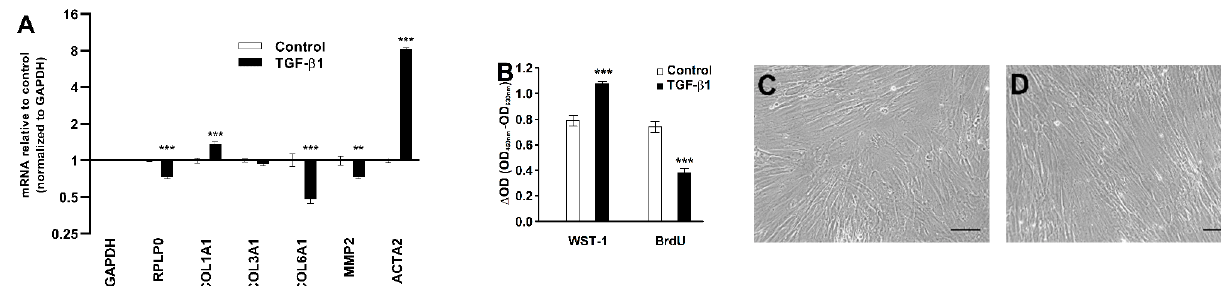
Figure 6. Effect of TGF- β 1 (1 ng/mL) treatment of CoReFs for 48 h on COL1A1 , COL3A1 , COL6A1 , MMP2 , and ACTA2 mRNA levels ( A ) and cell proliferation measured by WST-1/BrdU assays ( B ). Phase contrast photomicrographs (Olympus CK40 with Moticam ® S2) of CoReFs treated without ( C ) or with TGF- β 1 ( D ) for 48 h just before adding the WST-1 reagent. Scale bars, 100 µm. ( A ) mRNA levels were normalized to GAPDH , expressed as fold change relative to control-treated CoReFs and log-transformed. Geometric mean ± back-transformed SEM of 6 replicates is shown. ( B ) Mean ± SEM of 10 replicates is shown. ** p < 0.01, *** p < 0.001 vs. control.